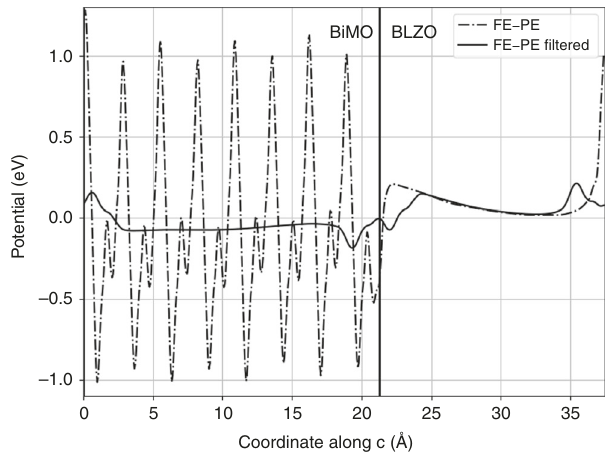
Fig. 6 Electric fi elds in BiMO/insulator superlattice. Filtered average of potential difference of polar-distorted and non-polar SLs, highlighting the sawtooth shape of the potential and the existence of a depolarizing fi eld.